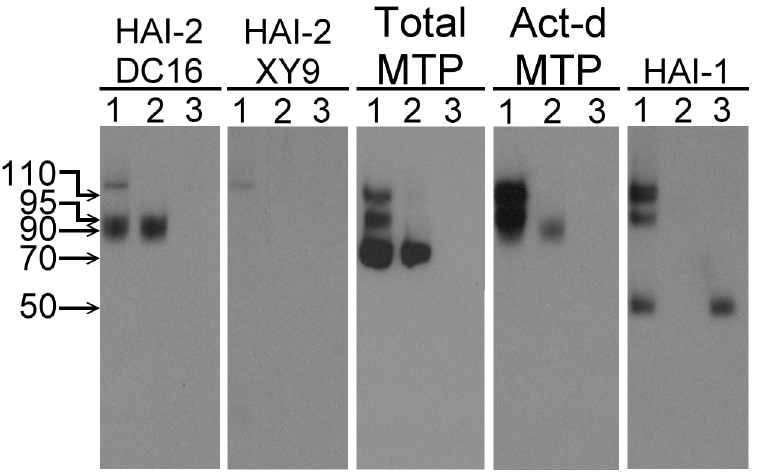
Fig 5. Activated matriptase is shed in complexes with HAI-1 and the HAI-2 species with N-glycan branching. Conditioned medium from MCF7 breast cancer cells was collected and subjected to immunodepletion using HAI-1 mAb M19-Sepharose or matriptase mAb 21-9-Sepharose. The conditioned medium (lanes 1), HAI-1-depleted conditioned medium (lanes 2), and matriptase-depleted medium (lanes 3) were analyzed by immunoblot for HAI-2 species with N-glycan branching using the mAb DC16 (HAI-2 DC16), HAI-2 species without N-glycan branching using the mAb XY9 (HAI-2 XY9), total matriptase using the mAb M24 (Total MTP), activated matriptase using the mAb M69 (Act-d MTP), and HAI-1 using the mAb M19